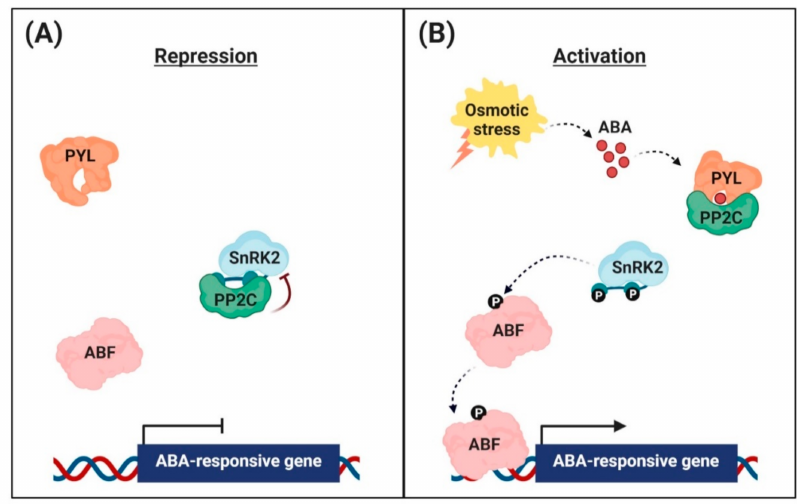
Figure 1. Abscisic acid (ABA) signaling pathway in the nuclei of guard cells. ( A ) Repression of ABA-responsive gene expression. In the absence, the clade A protein phosphatases (PP2Cs) physically interact with the sucrose non-fermenting 1-related protein kinases (SnRK2s) to reduce kinase activity via dephosphorylation. This inhibits the activity of ABRE-binding (AREB) / ABRE-binding factor (ABF) transcription factors and suppression of ABA-responsive gene transcription. ( B ) Activation of ABA-responsive gene expression. Under osmotic stress conditions, the interaction with ABA leads to conformational changes in the ABA receptors [PYR (pyrabactin resistance) / PYL (PYR-related) / RCAR (regulatory component of the ABA receptor)], allowing them to interact with PP2Cs. PP2Cs act as a coreceptor to capture ABA, thereby suppressing its phosphatase activity. This sequestrates PP2Cs from SnRK2s, and free SnRK2s phosphorylate the downstream transcription factors AREB / ABFs. The phosphorylated AREB / ABFs trigger the transcription of numerous ABA-responsive